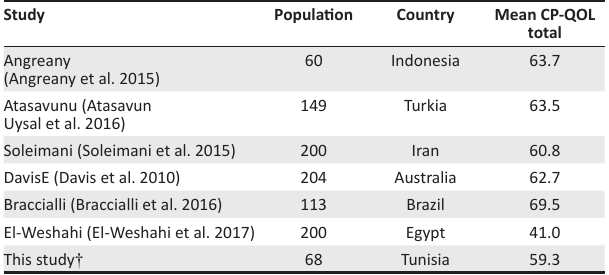
TABLE 6: Comparative table of the means of total score of cerebral palsy quality of life questionnaire between the different studies in the literature. Study Population Country Mean CP-QOL